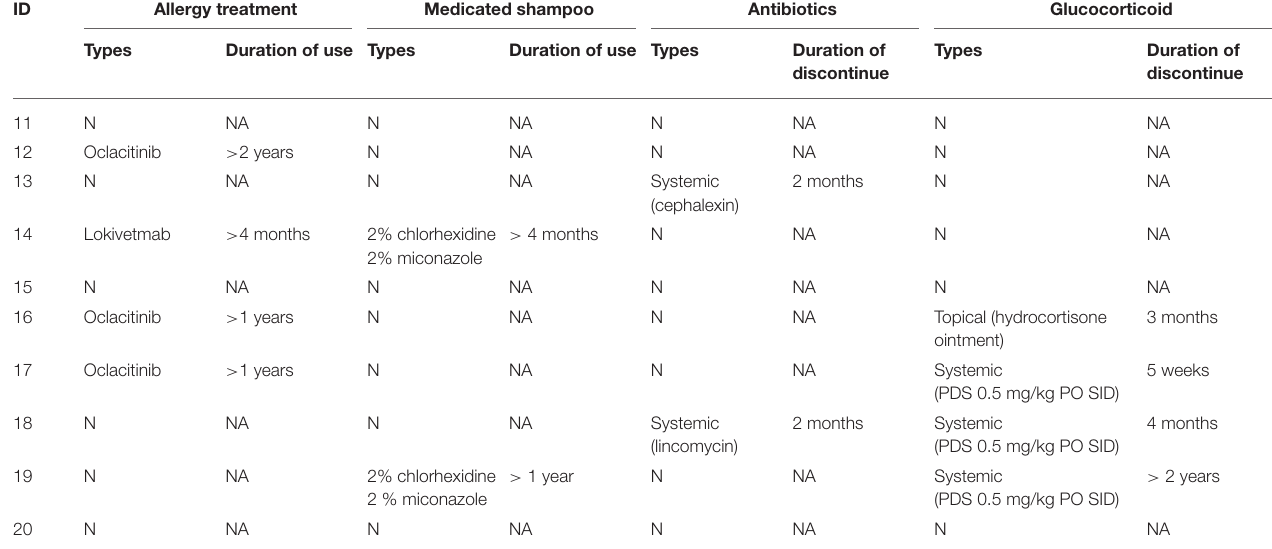
TABLE 3 | Medical history of the allergic